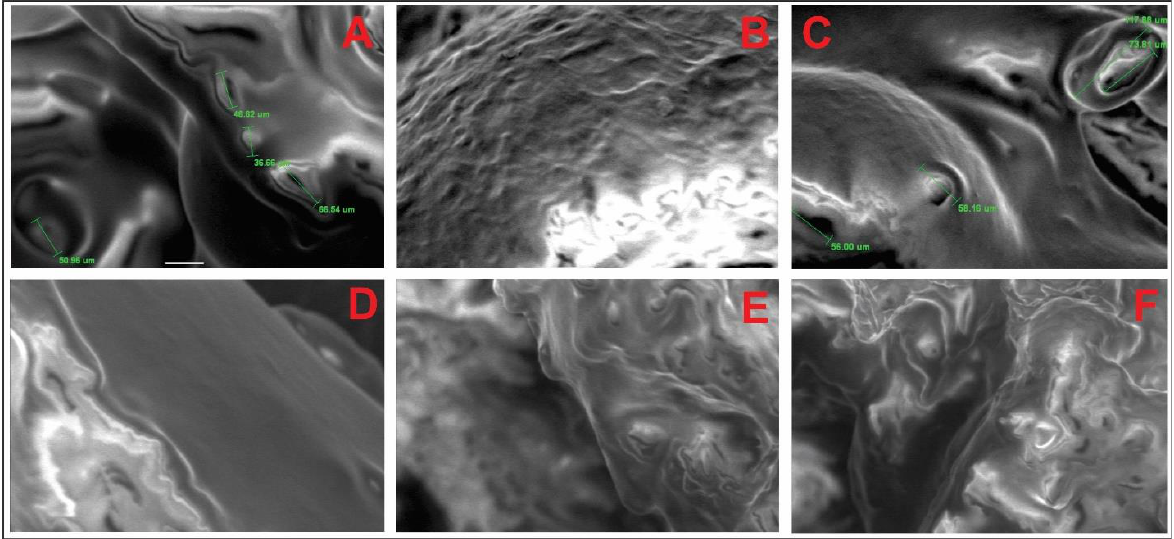
Figure 7. SEM images of modified bitumen. ( A ) Bitumen + 3% polymer waste. ( B ) Bitumen + 3% SBS. ( C ) Bitumen + 3% polymer waste + 1% SBS. ( D ) Bitumen + 1% polymer waste + 3% SBS. ( E ) Bitumen + 2% polymer waste + 3% SBS. ( F ) Bitumen + 3% polymer waste + 3%